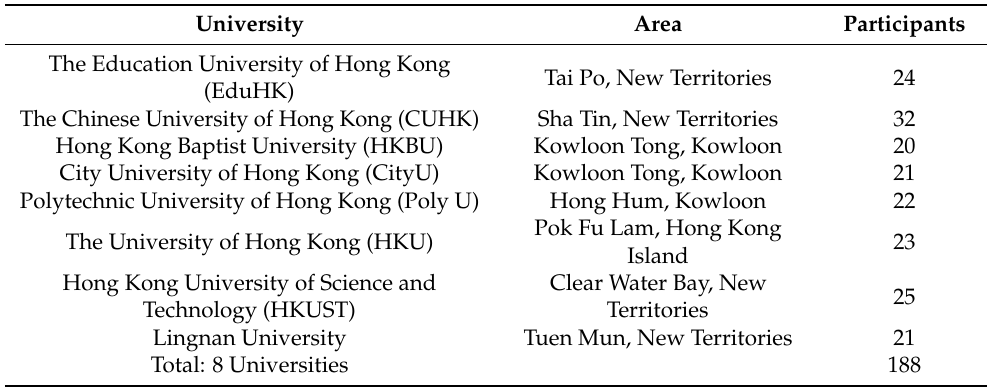
Table 1. Sampling location and sample size.